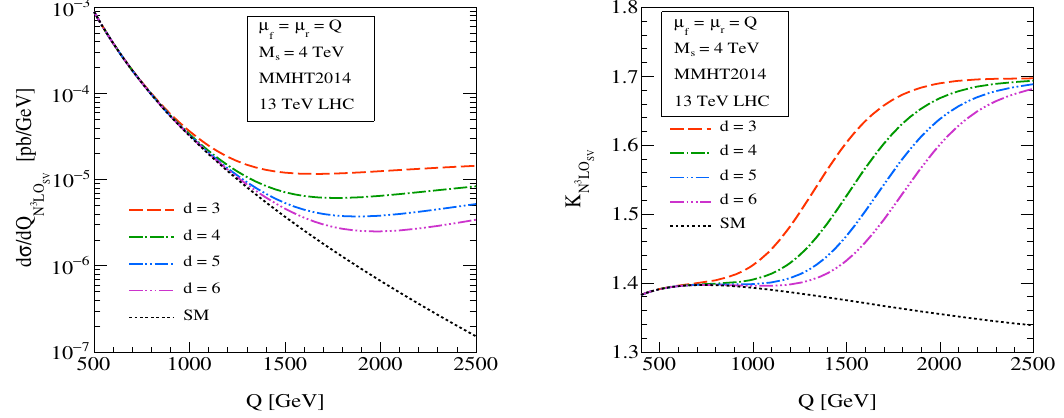
Figure 4 . Variation of number of extra dimensions d keeping M S = 4 TeV. Invariant mass dis- tribution is shown at the left panel and their corresponding K-factors are on the right panel at N 3 LO sv